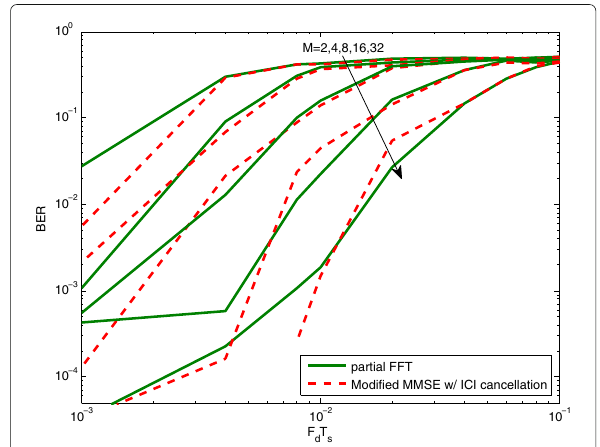
Fig. 9 BER performance against normalized Doppler frequencies, N s = 512, SNR = 30